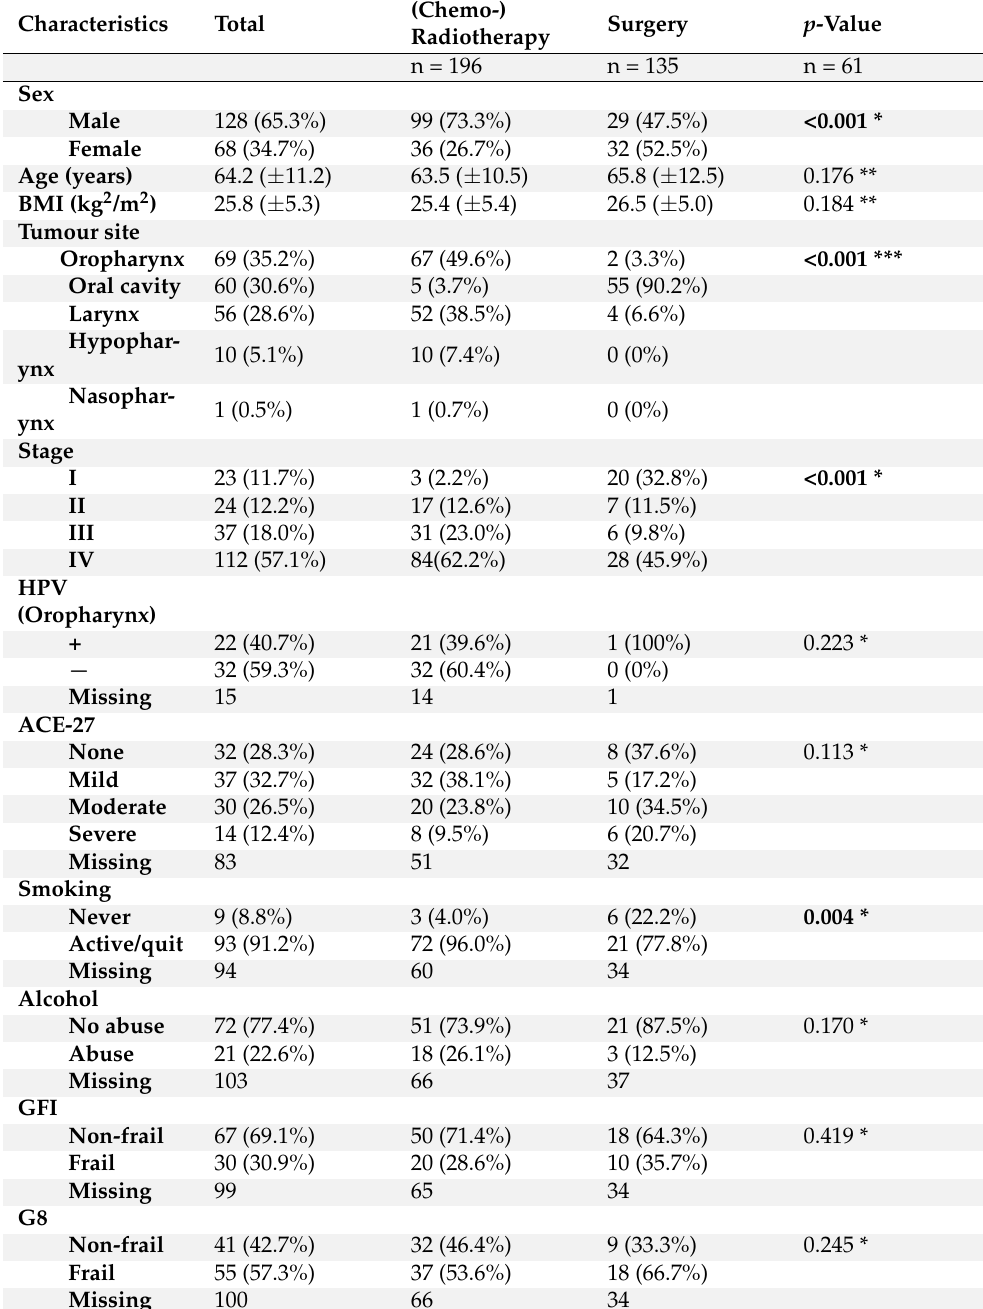
Table 1. Baseline characteristics of total cohort and differences between patients treated with (chemo-)radiotherapy and